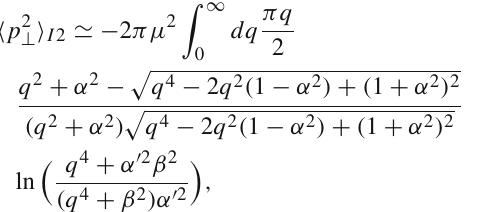
Fig. 12 Comparison of the three contributions to (cid:2) p 2 ⊥ (cid:4) NLO, 1 from the three lines of Eq. (41) for L = 5 fm and μ = 0 . 5 GeV: the small shift, small x contribution from the first line of Eq. (41) (dashed); the small shift,large x contributionfromthesecondlineofEq.(41)(dash-dotted); the large shift contribution from the third line of Eq. (41) (dotted); and the sum of the three contributions